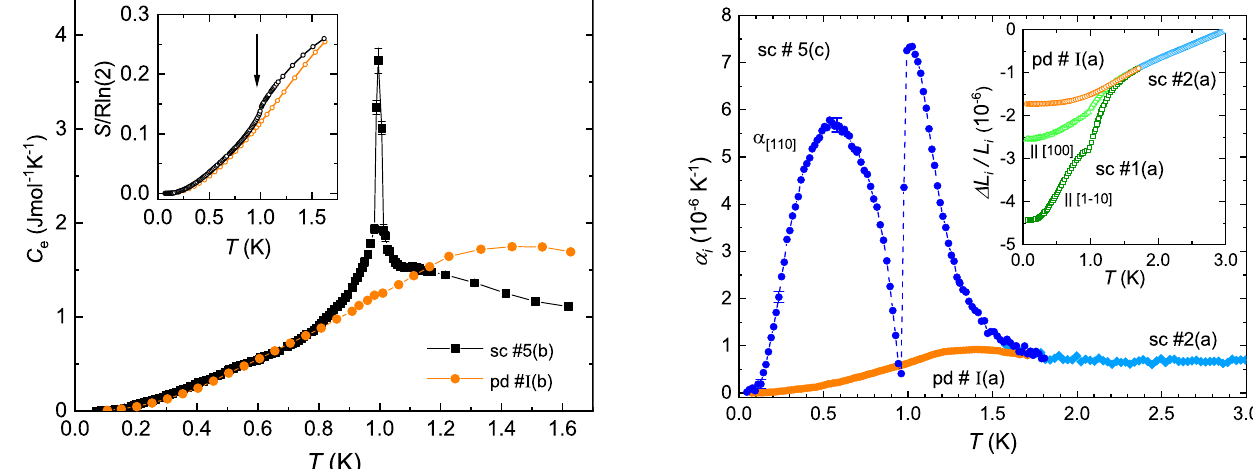
Fig. 2 Temperature dependence of the coef fi cient of thermal expansion of PbCuTe 2 O 6 . Thermal expansion coef fi cient α for single crystal sc #5(c) (dark blue spheres) and sc #2 (light blue diamonds for T ≥ 1.5 K), both measured along the [110] direction, together with data for the pressed-powder sample pd # Ι (a) (orange spheres). Broken line serves as a guide to the eyes. Representative error bars resulting from the statistical treatment of raw data and systematical uncertainties related to the determination of the sample length. Error bars of measurement for pd sample are within symbol size. The inset shows relative length changes Δ L i ( T )/ L i for sc #1(a), measured along [100] (light green triangles) and [1 – 10] (dark green squares), sc #2 (light blue diamonds) for T ≥ 1.5 K, and for the powder sample pd # Ι (a) (orange spheres). The pronounced anomaly in α [110] for T ≤ 1.5 K is consistent with a strong decrease observed in the longitudinal elastic constant c L[110] upon cooling, see Fig. 8 and Note 5 in